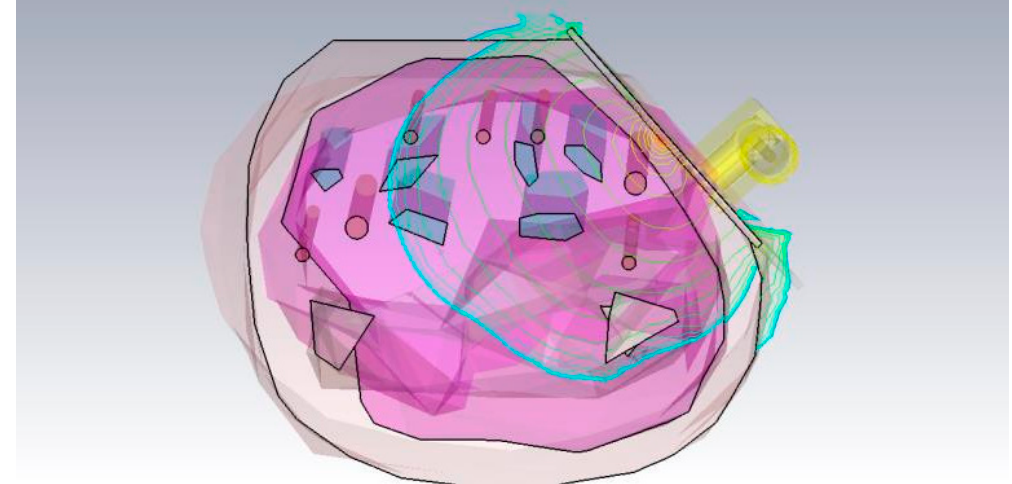
Figure 4. CST Microwave Studio simulation qualitative power flow in the resonator and the human body model, logarithmically